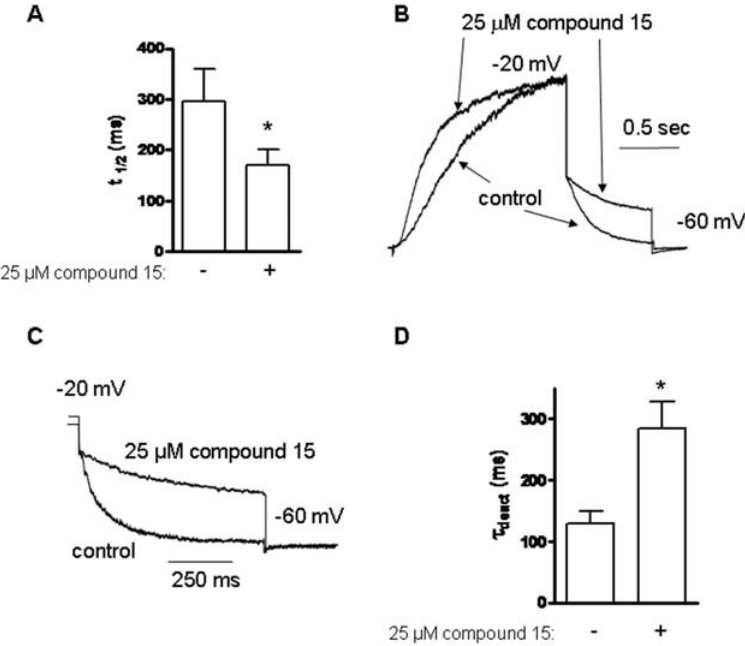
Figure 6. Effect of compound 15 on activation and deactivation kinetics of Kv7.2/3 channels. (A) Activation kinetics were evaluated at 2 20 mV by determining t 1/2 , the time value at which half of the current amplitude developed, in the absence or presence of 25 m M compound 15 (n=4; * p , 0.02). (B) Representative normalized trace of current activation in the absence and presence of 25 m M compound 15. (C) Representative normalized trace of current deactivation at 2 60 mV in the absence and presence of 25 m M compound 15. (D) At 2 60 mV, deactivation kinetics were fitted by one exponential function and the time constant was measured in the absence and presence of 25 m M compound 15 (n=4; * p , 0.02).